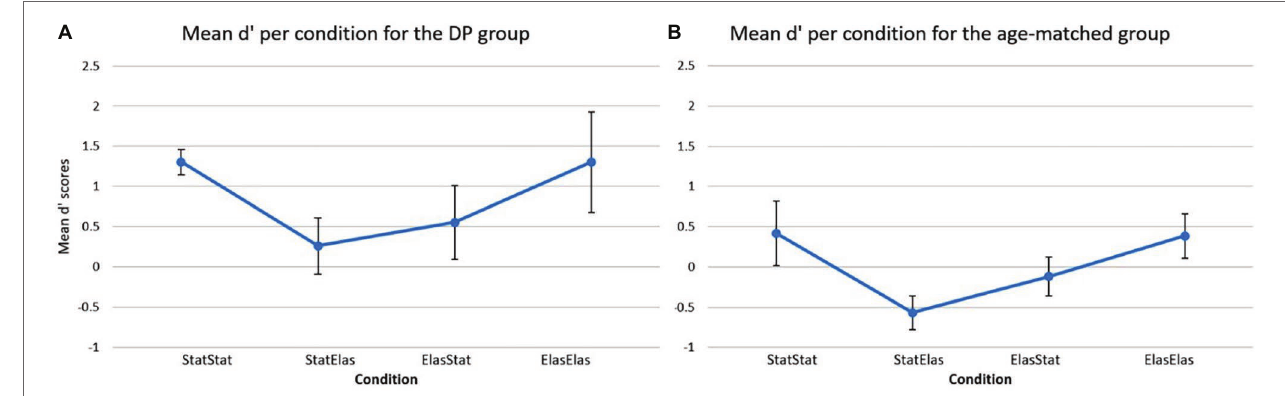
FIGURE 3 | Mean d’ scores (and error bars) per condition for the DP group (A) and for the age-matched controls (B) . The DP group showed higher sensitivity rates in all conditions compared to the age-matched group. The age-matched group showed the lowest sensitivity in the static-elastic condition and similar sensitivity rates in the static-static and elastic-elastic conditions. A similar profile can be detected in the DP